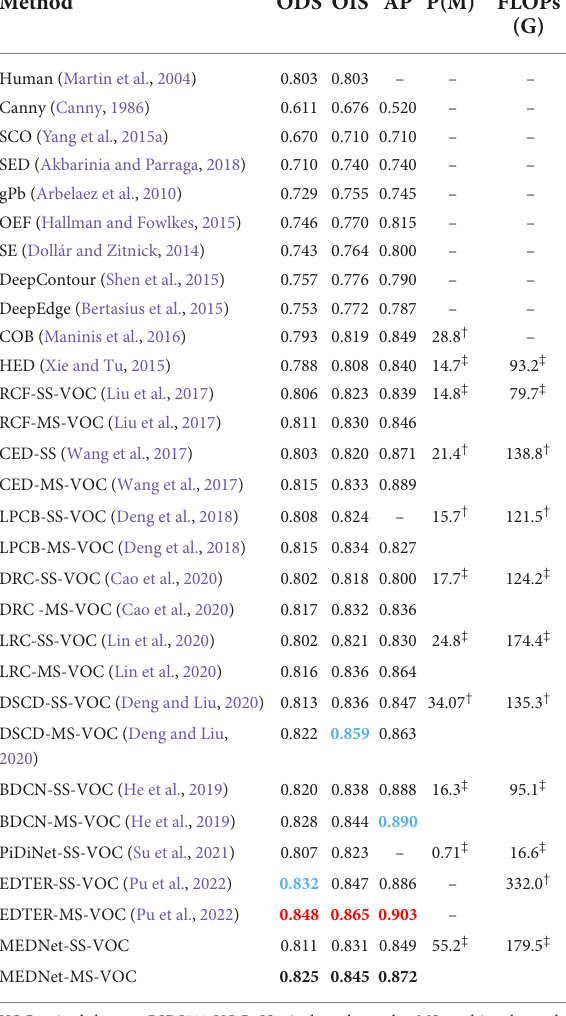
TABLE 3 Quantitative comparison results between the proposed method and other methods on the BSDS500 test